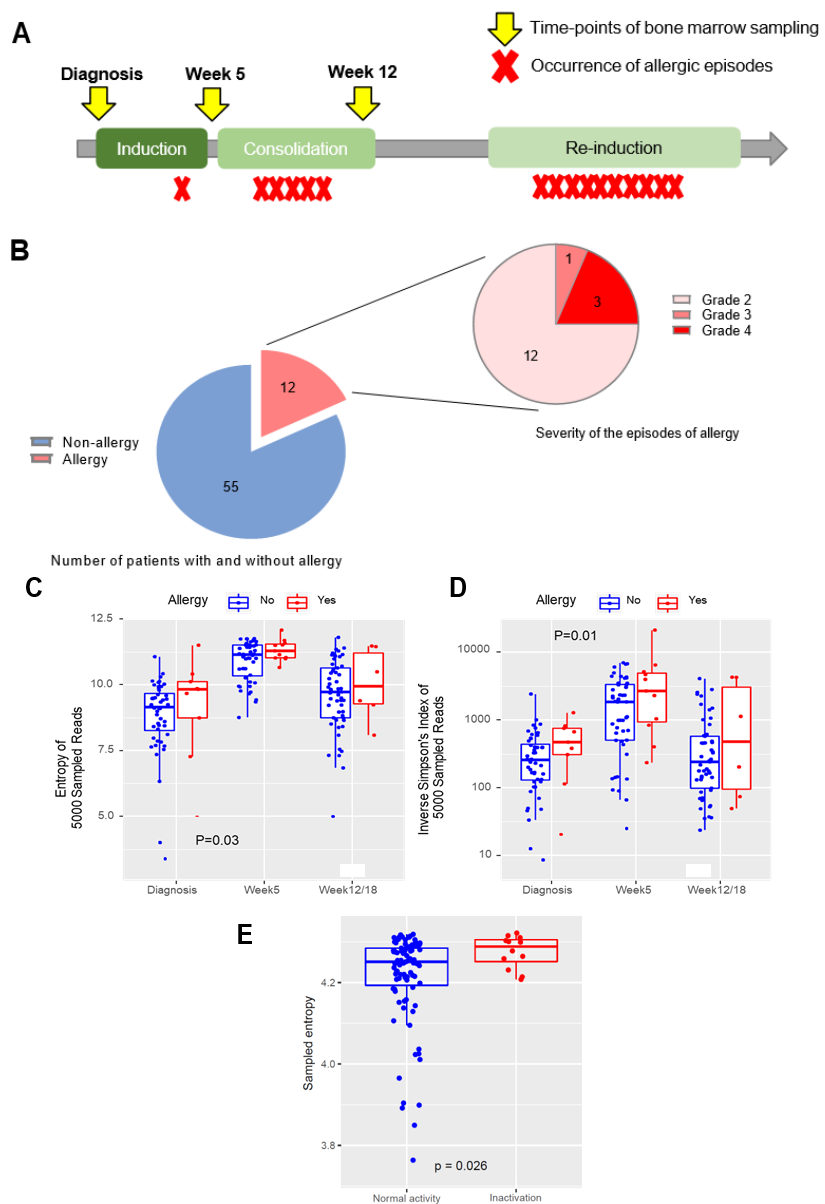
Figure 1. L-asparaginase allergy in childhood ALL, and the association of TCR-B diversity with oc- currence of subsequent allergy: ( A ) Overall study schema. The phases of chemotherapy in the Ma- Spore 2010 protocol are shown, with timepoints of bone marrow sampling indicated by yellow ar- rows and occurrences of allergic episodes indicated by red crosses. ( B ) Number of patients with allergy in the cohort, and the distribution of allergy grades amongst the allergy episodes. The left pie chart depicts the proportion of patients with allergy (in red), and the right pie chart depicts the distribution of severity of 16 episodes of allergy. ( C ) Shannon’s entropy in non-allergy vs. allergy groups throughout all timepoints. Shannon’s entropy is plotted for each patient in the scatterplot at each timepoint and compared between pre-allergic and non-allergic patients; p -values determined by the Mann – Whitney test. ( D ) Inverse Simpson’s index in non -allergy vs. allergy groups through- out all timepoints. The i nverse Simpson’s index is plotted for each patient in the scatterplot at each timepoint and compared between pre-allergic and non-allergic patients. Both Shannon’s entropy and the inverse Simpson’s index are higher in pre-allergic patients at all timepoints, indicating a higher TCR repertoire diversity in this group of patients who would later go on to develop allergy. p -Values determined by the Mann – Whitney test. ( E ) Shannon’s entropy in normal L-asp activity vs. L-asp inactivation in the functional validation cohort. Shannon’s entropy is plotted for each patient in the scatterplot and compared between patients with normal L-asp activity (blue) and patients with L-asp inactivation (red). L-asp inactivation is defined as an activity level of <100 U/L. p -Values